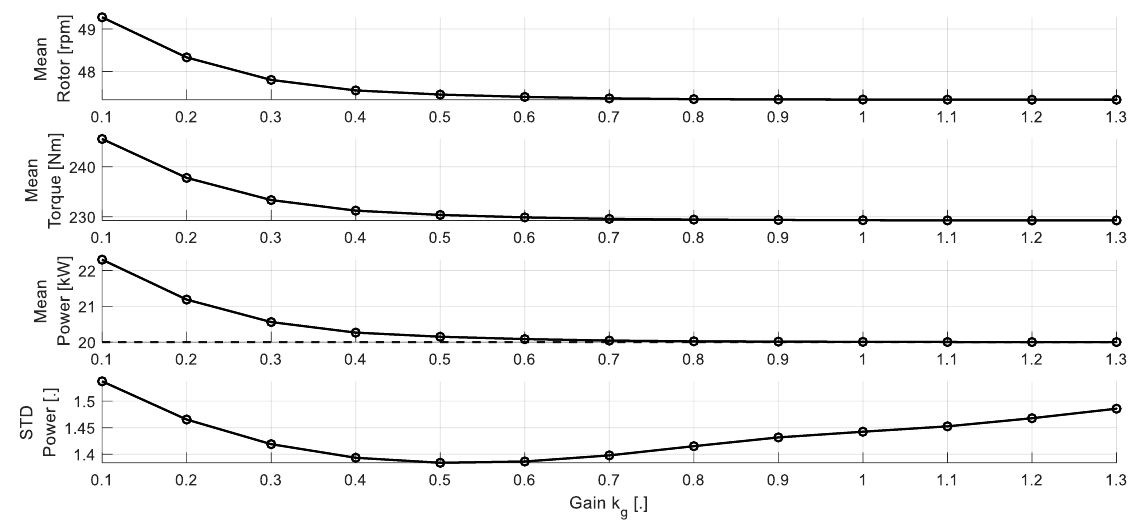
Figure 10. Output performance of proposed controller with different gains of 𝑘 𝑔 .